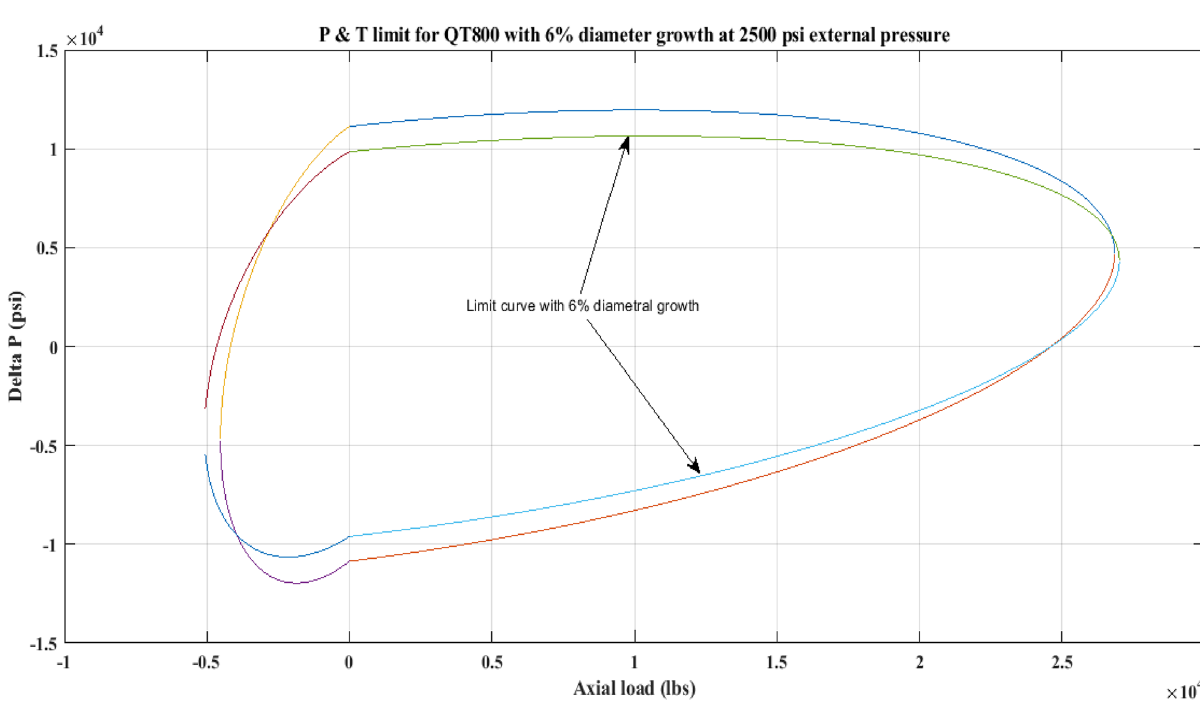
Figure 8. P and T limit with diameter growth for QT800 at 2500 psi P o